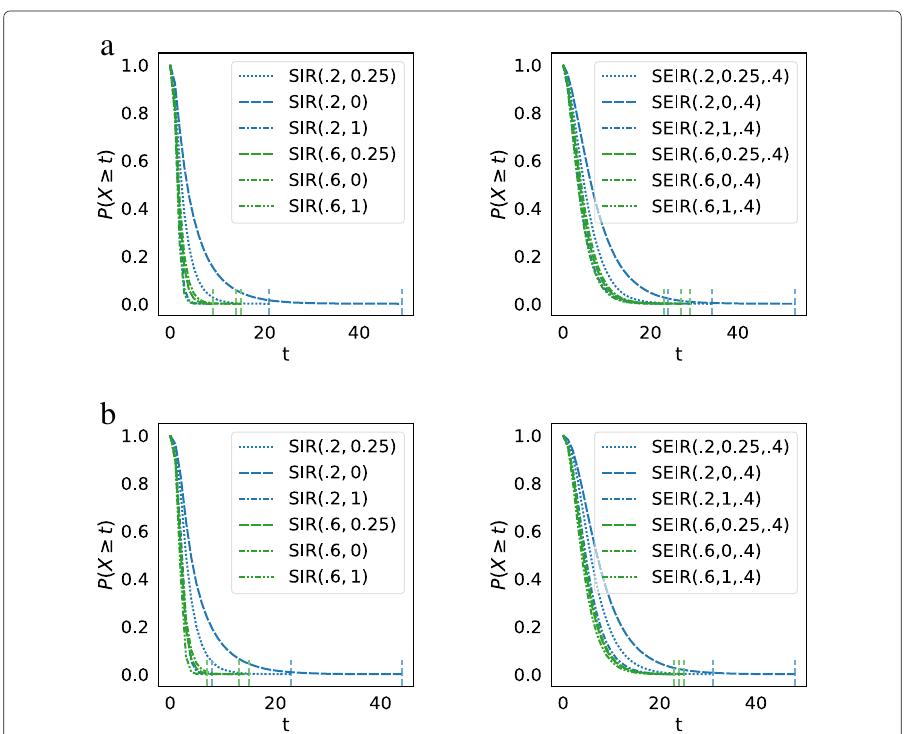
Fig. 21 Complementary cumulative distribution functions of node infections for SIR and SEIR with β ∈ { 0.2,0.6 } , γ ∈ { 0,0.25,1 } ), and σ = 0.4, using k = 50 and strategy I-Sources. a Epinions. b Slashdot